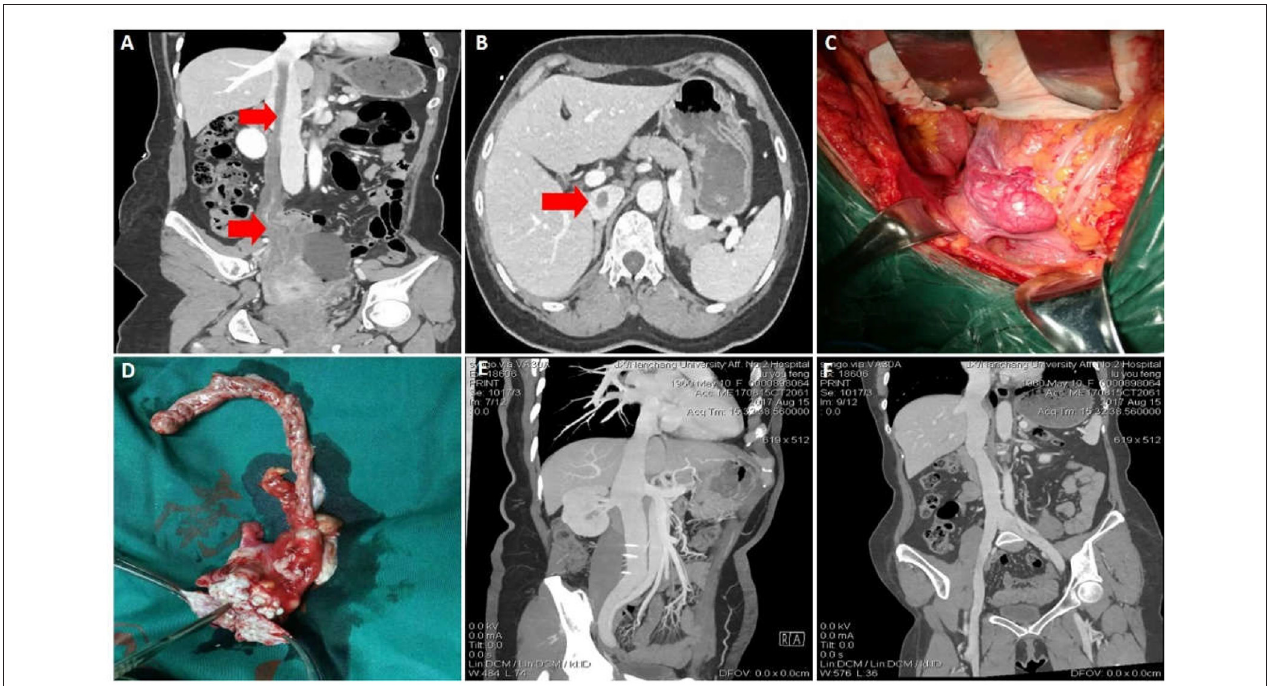
FIGURE 2 | Data of case 2 before, during, and during follow-up. (A,B) Preoperative CTV and abdominal CT scan showed a mass extended through the right ovarian vein to the huge occupying lesion in the inferior vena cava. (C) Inferior vena cava tumor and right ovarian vein were removed, and the right adnexa and part of uterus were also removed. (D) The intact mass was removed. (E,F) Eight months after surgery, CTV confirmed that the inferior vena cava was unobstructed and the prognosis was